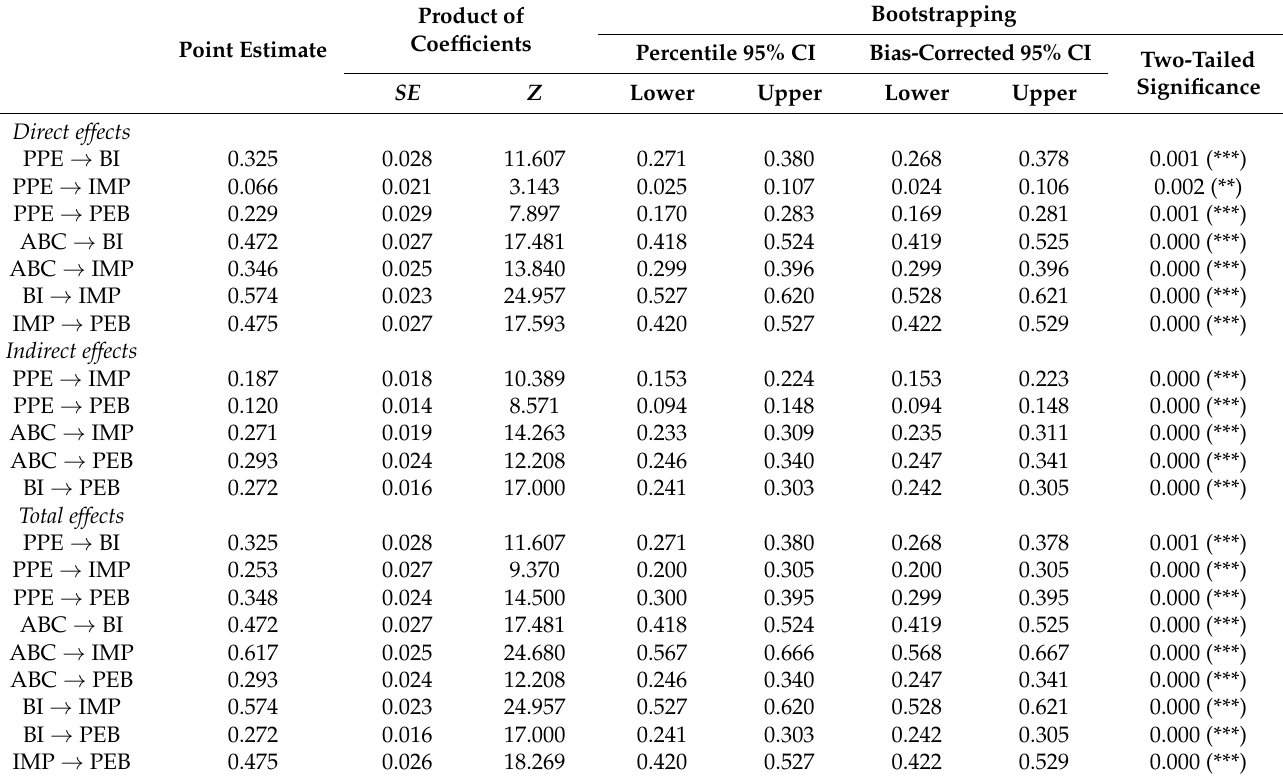
Table 6. Standardized direct, indirect, and total